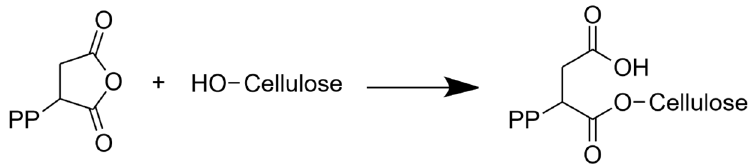
Figure 6. PP-MAH coupling agent bonding to the surface of a cellulose fibril.